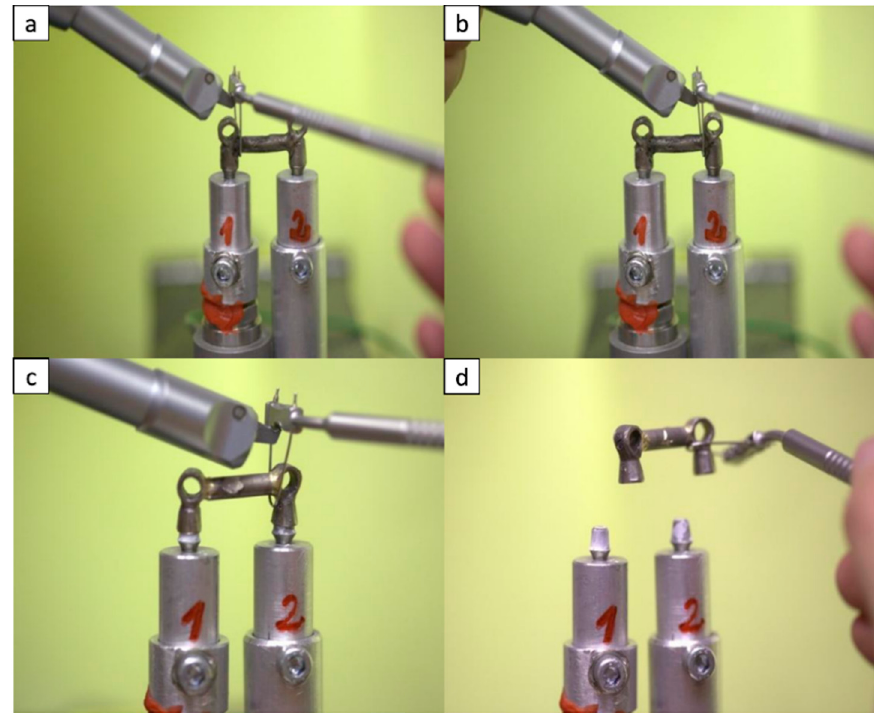
Figure 3. Test protocol: ( a ) impulses delivered near to the most retentive abutment, ( b ) impulses delivered at the other abutment, ( c ) cement fracture, ( d ) complete bridge removal.